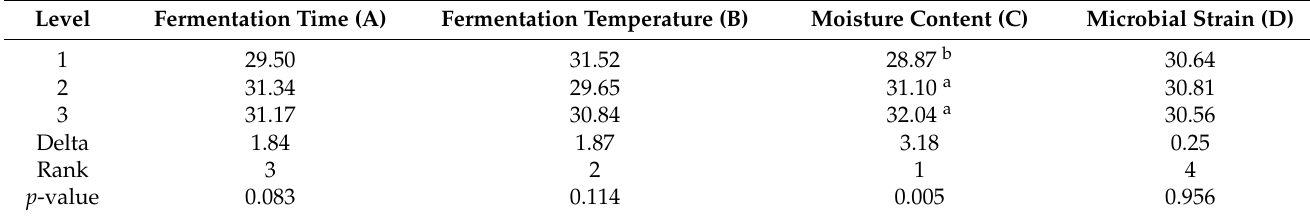
Table 6. Effects of different factor levels on NDF of TMR with RSM.